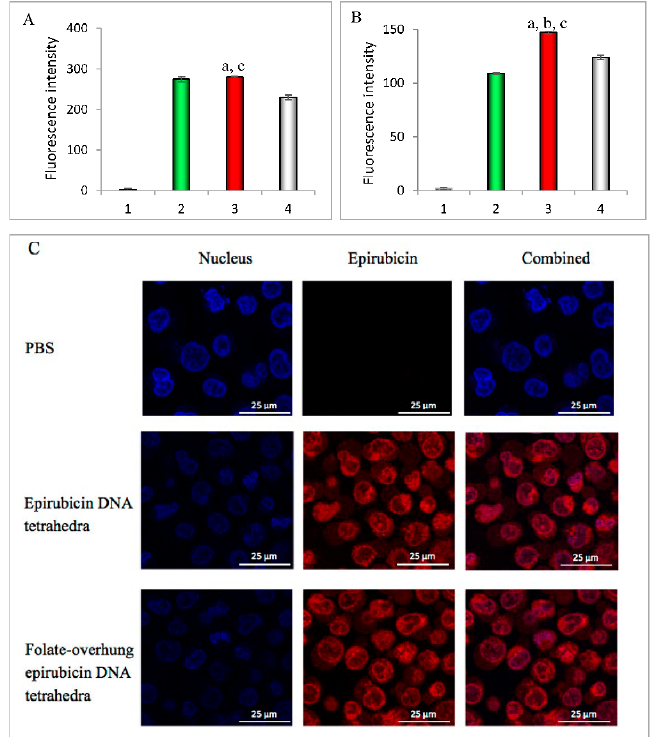
Figure 2. Targeted capture of folate-overhung DNA tetrahedra by leukemic cells and their co- localization into nuclei, by transport across the nuclei membrane. Epirubicin was used as a fluorescent probe for indicating folate-overhung epirubicin DNA tetrahedra. ( A ). Cellular uptake by BALL-1 cells indicated with the fluorescence intensity; ( B ). Cellular uptake by K562 cells indicated with the fluorescence intensity. For ( A ) and ( B ): 1. PBS; 2. Epirubicin DNA tetrahedra; 3. Folate-overhung epirubicin DNA tetrahedra; 4. Folate-overhung epirubicin DNA tetrahedra after saturation with excess of folate. a. vs. PBS; b. vs. epirubicin DNA tetrahedra; c. vs. folate-overhung epirubicin DNA tetrahedra after folate saturation. p < 0.05 ( C ). The co-localization of drug with nuclei of leukemia K562 cells.